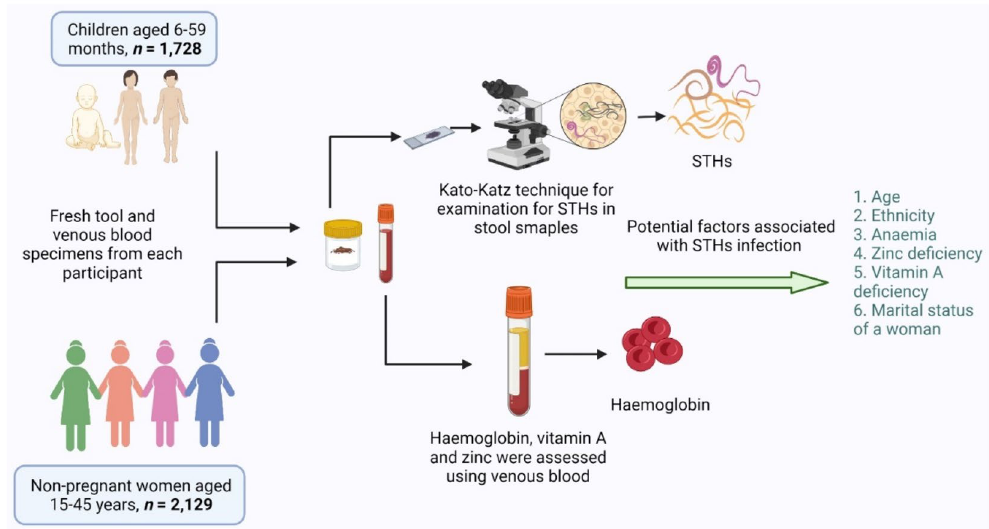
Figure 2. Graphical summary of the study design and major findings, figure was created with